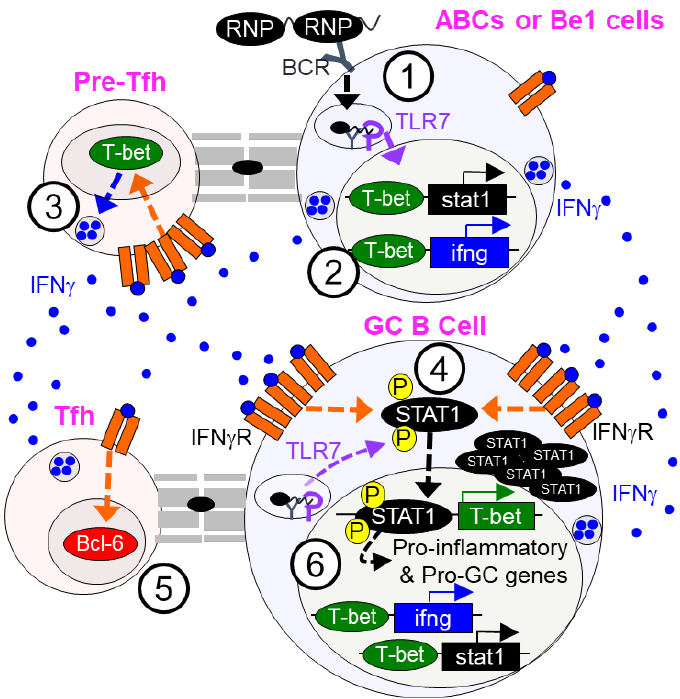
Figure 2. Type 2 interferon signaling in the germinal center. (1) B cell receptor cross-linking by self-antigen immune complexes activates TLR7 to induce (2) Tbet-mediated production of IFN γ in age-associated B cells (ABCs) and B effector 1 (Be1) cells. (3) Cognate interaction of B cells with T cells outside of the germinal center allows pre-T follicular helper (pre-Tfh) cells (CD4 + CXCR5 Int PD1 Int ) to produce IFN γ . (4) Within the GC, Tfh-derived IFN γ signals in B cells to induce the phosphorylation of STAT1 (at Y701) to promote Tbet transcription and further IFN γ production. (5) In fully differentiated GC-Tfh (CD4 + CXCR5 Hi PD1 Hi ) cells, IFN γ signaling increases BCL6 production and promotes GC stability. (6) Finally, combined TLR7, BCR, and IFN γ signaling in GC B cells promotes the phosphorylation of STAT1 at two phosphorylation sites (Tyr 701 and Ser 727), allowing for the full activation of STAT1-mediated GC stability and pro-inflammatory gene